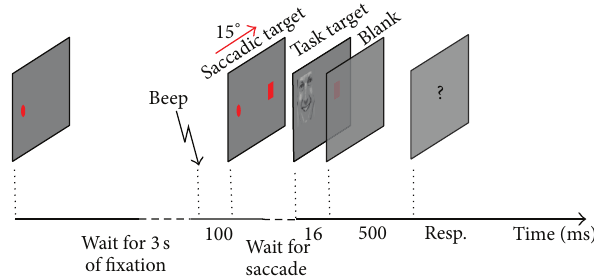
Figure 1: Schematic view of one trial: after 3 seconds, an auditory cue initiates the saccade followed by visual saccadic target. As soon as the saccade is detected, one visual stimulus (face or scramble) is presented, followed by a blank screen. Next, the task-relevant question is displayed on the